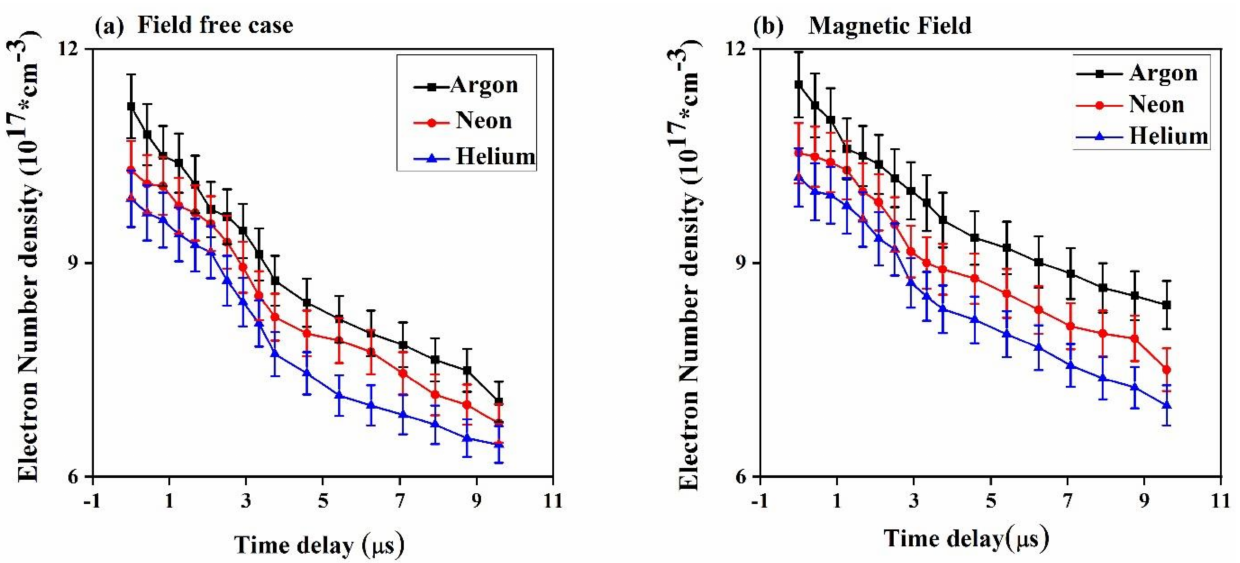
Figure 8. The variation in electron number density of LPP of Mg alloy at different time delays in ( a ) the absence and ( b ) the presence of a magnetic